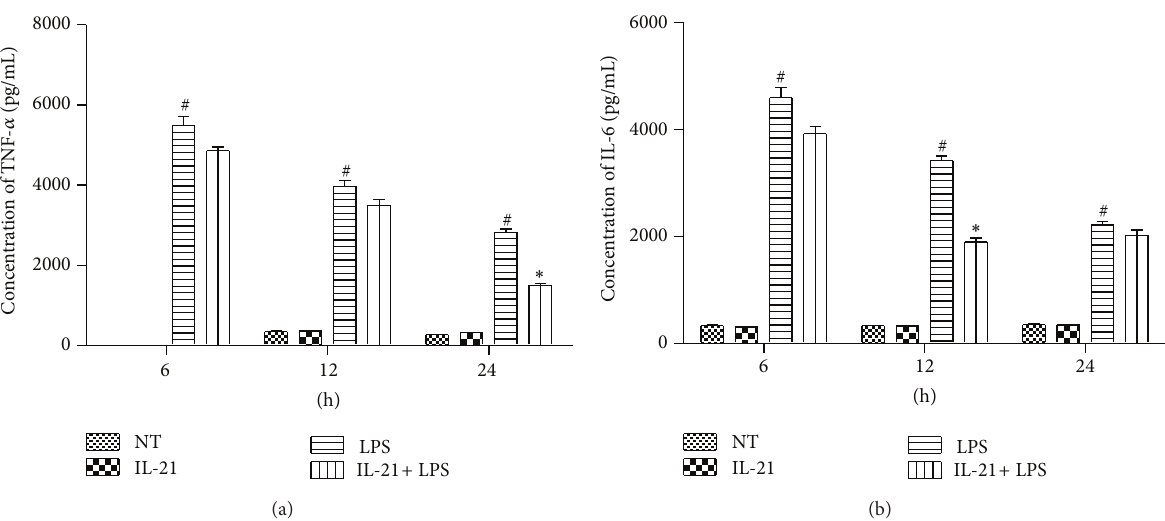
Figure 3: Effects of IL-21 on LPS-induced TNF- 𝛼 and IL-6 secretion in mouse peritoneal macrophage culture supernatants Macrophages were incubated with IL-21 (100ng/mL) in the presence or absence of LPS (100ng/mL) for 6h, 12h and 24h. The concentration of TNF- 𝛼 (a) and IL-6 (b) were measured by ELISA. Values are presented as mean ± SD of three independent experiments. # 𝑃 < 0.001 significantly different from the NT group; ∗ 𝑃 < 0.05 , ∗∗ 𝑃 < 0.01 compared with the LPS